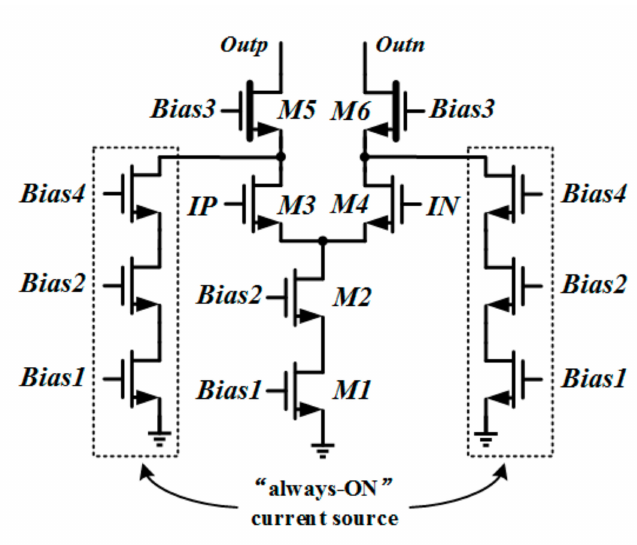
Figure 3. Switching current cell with “always-ON” current